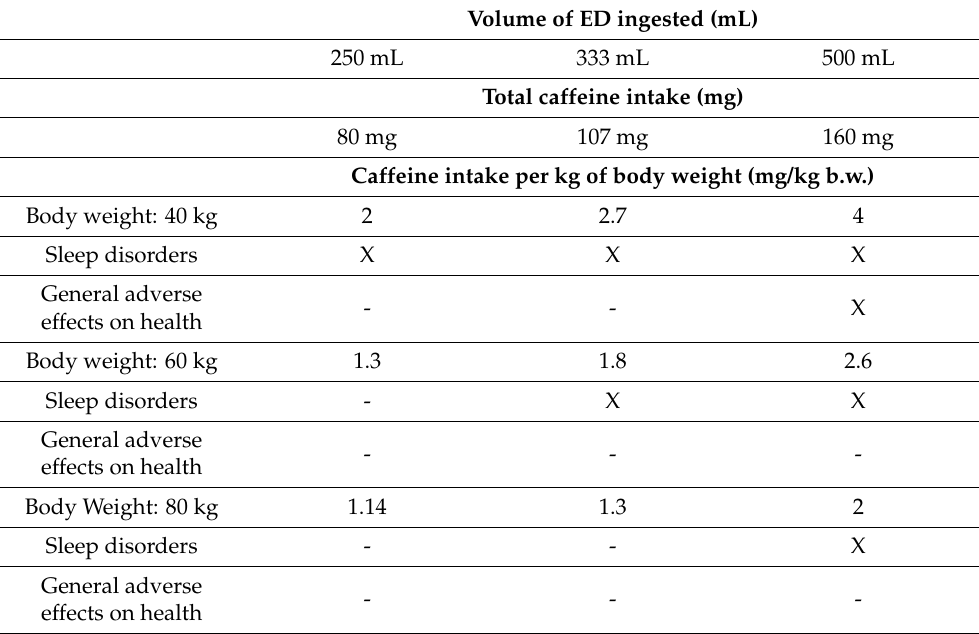
Table 1. Caffeine: dietary exposure assessment and risk characterization when consuming 250, 333 and 500 mL of 32 mg caffeine/100 mL